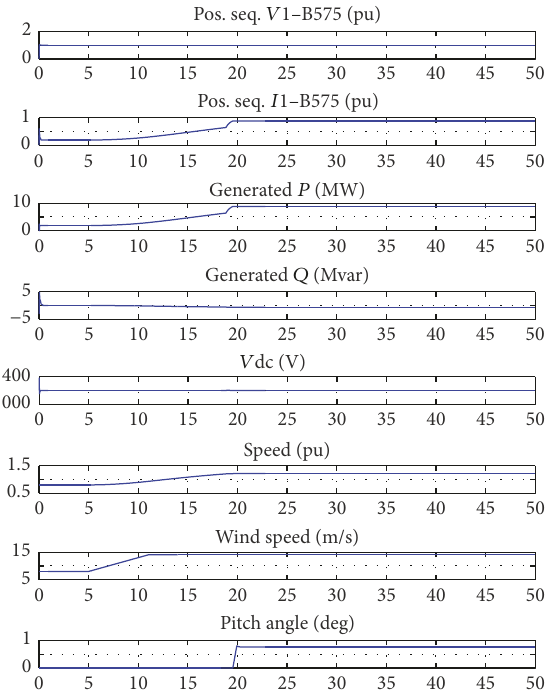
Figure 15: Simulation results for normal operation with step change increase in wind speed from 8 m/s to 14 m/s at 5-second mark.